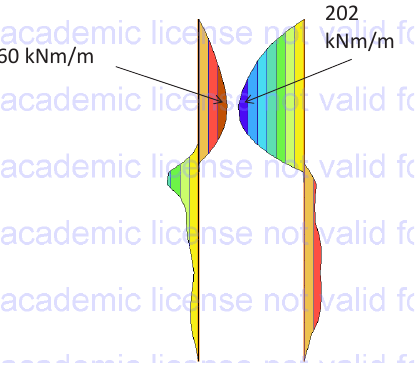
Figure 10: Bending moment envelopes, shallow excavation protected by sheet pile walls with strut at the top, SF = 1.25 (EC-7